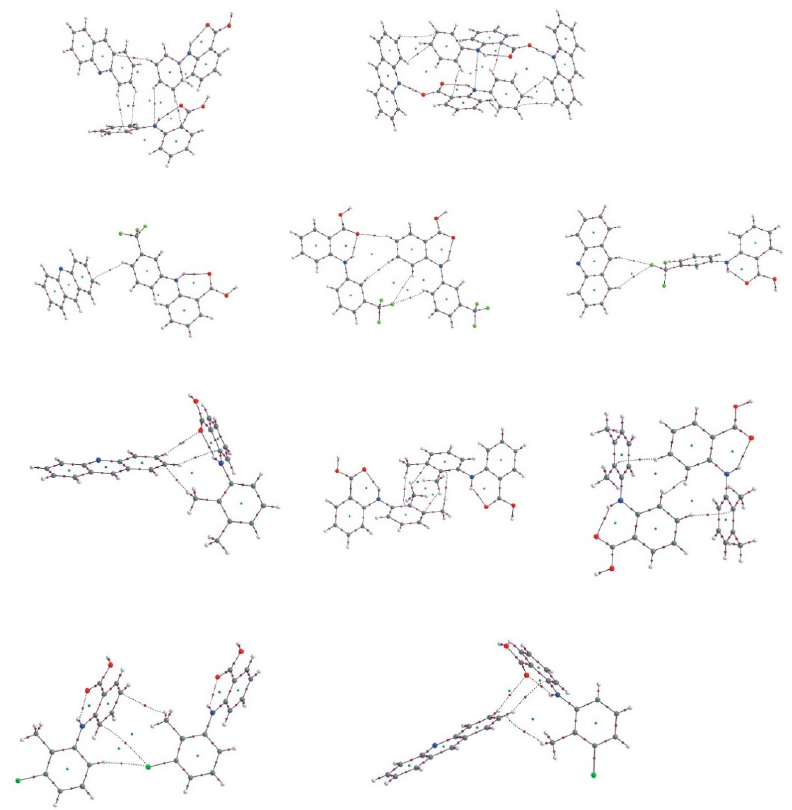
Figure 10. QTAIM diagrams for weak intermolecular interactions in the fenamic acids–acridine complexes.